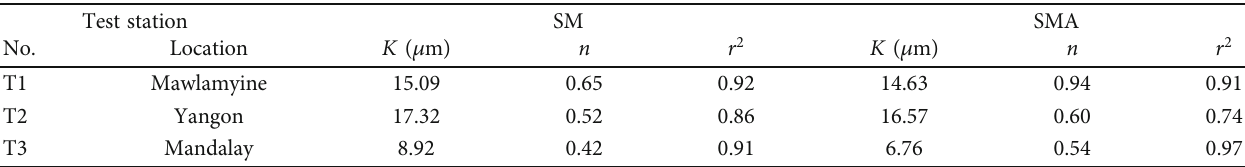
Figure 5: Logarithmic plots of corrosion loss ( μ m) as a function of time exposed at the sites T1 (a), T2 (b), and T3 (c). Table 6: Corrosion kinetic parameters K , n , and coe ffi cient of r 2